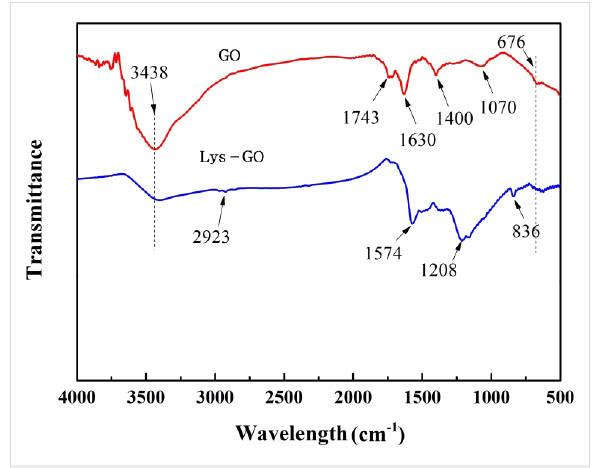
Figure 1: FTIR analysis of the obtained GO and